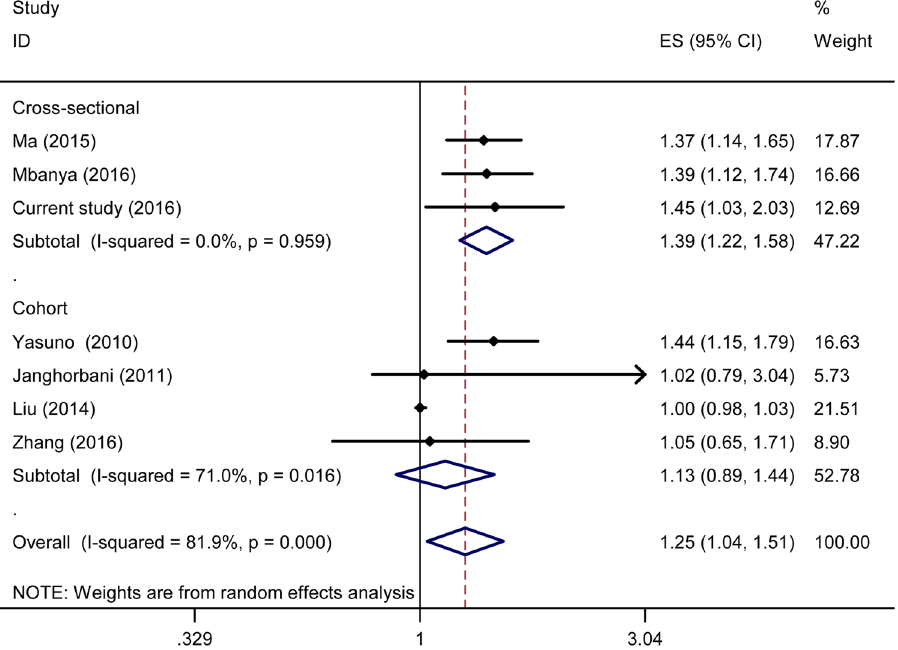
Figure 2. Forest plot of pulse pressure and diabetes risk for the selected